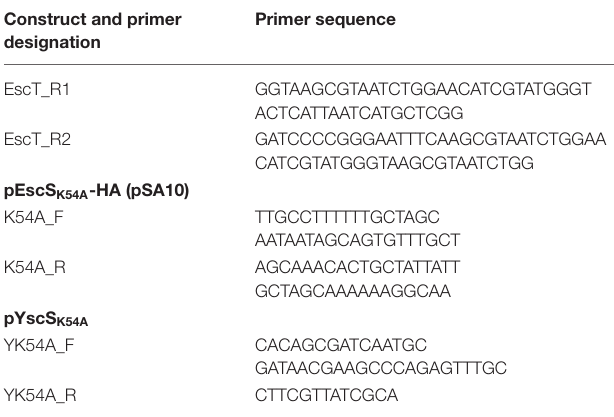
TABLE 2 | Sequences of primers designed and used in this